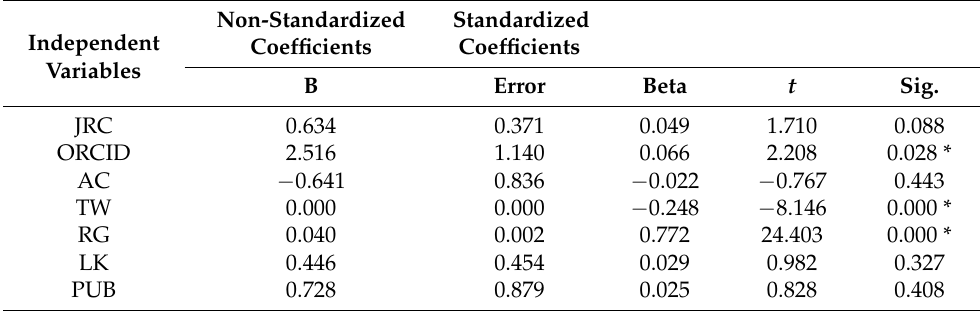
Table 5. Estimation of Model 1.